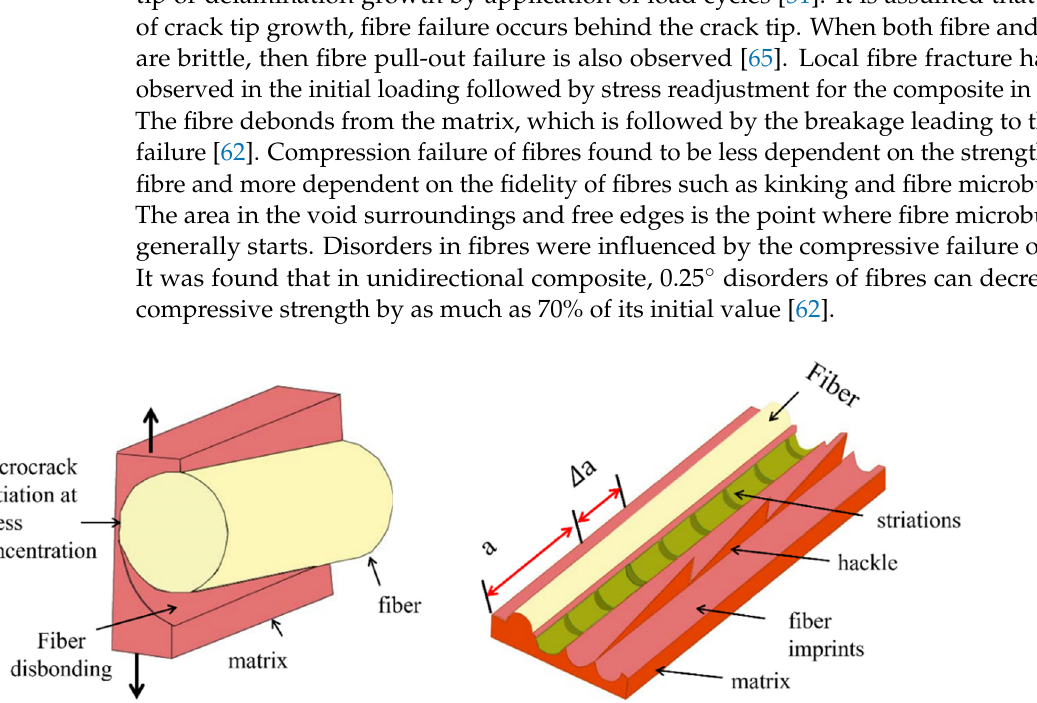
Figure 13. SEM images of fractured surfaces under mode I fatigue loading( a ) at short crack length ( b ) at long crack length.